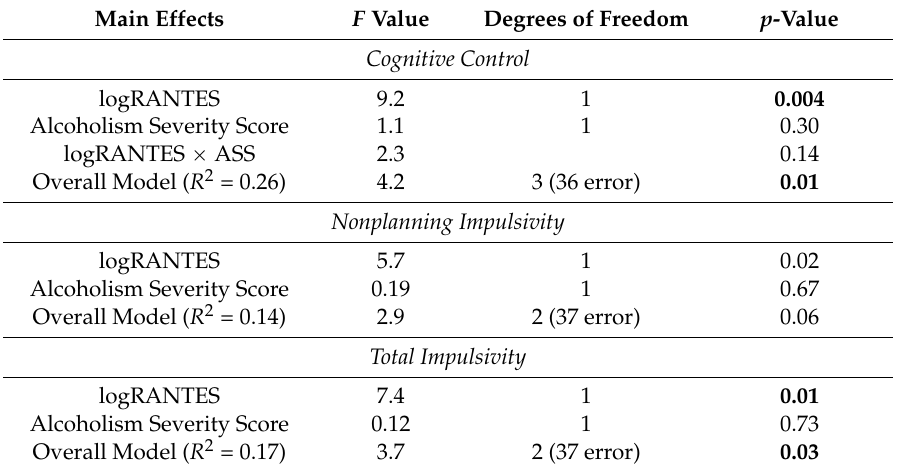
Linear regression model of logRANTES levels on BIS subscales. Bold numbers indicate statistical significance at p < 0.05.